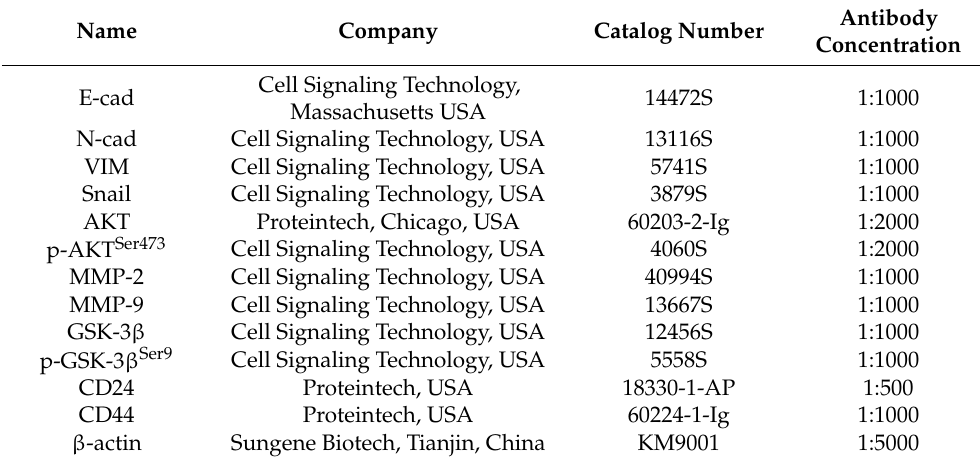
Table 2. Antibodies used for western blotting